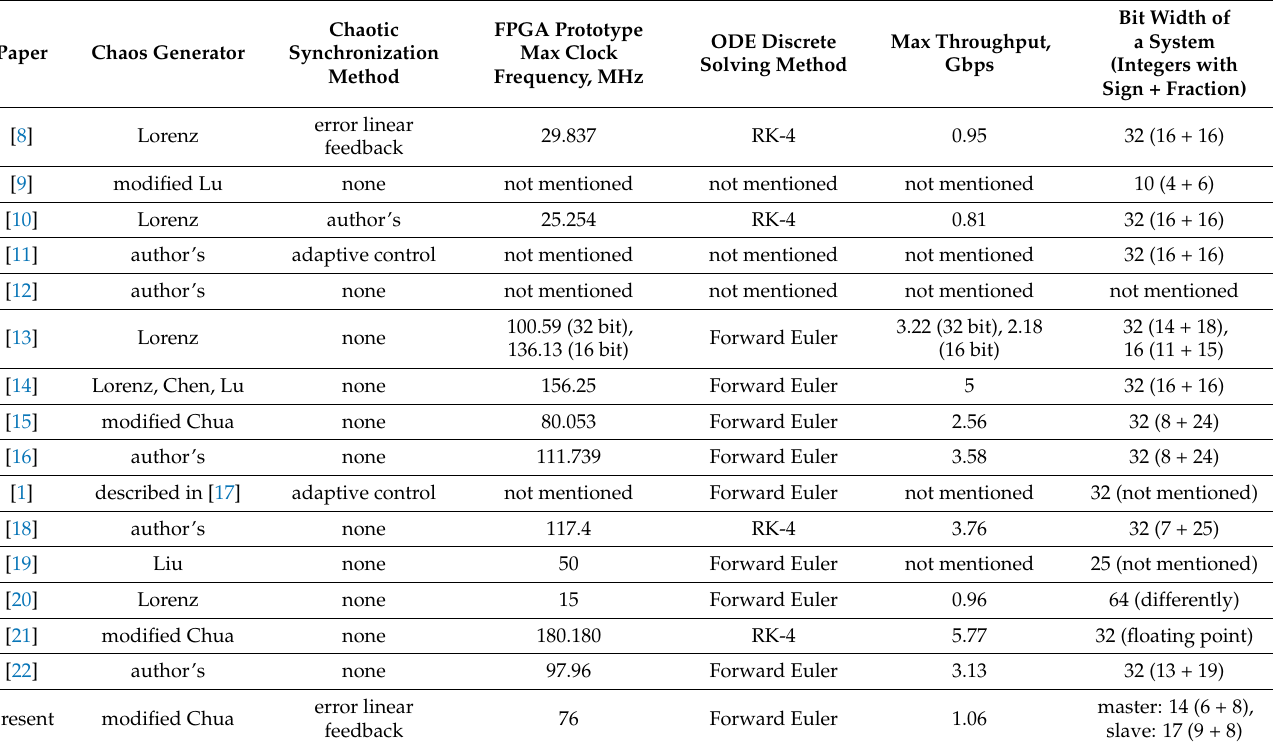
Table 1. Summary of chaos generators and chaotic synchronization (if applicable) implemented in